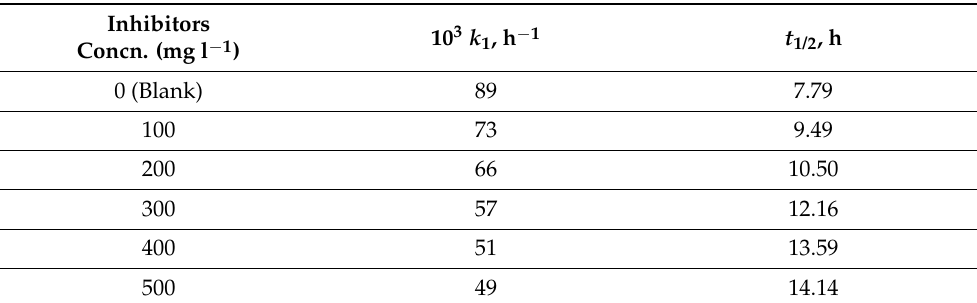
Table 7. Values of k 1 and t 1/2 for mild-steel corrosion in 0.5 M HCl solution in the absence and presence of chitin at 303 K.